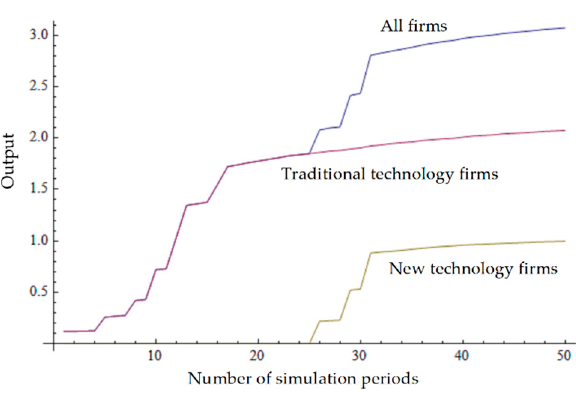
Figure 2. Change in the output of the fuel ethanol industry.